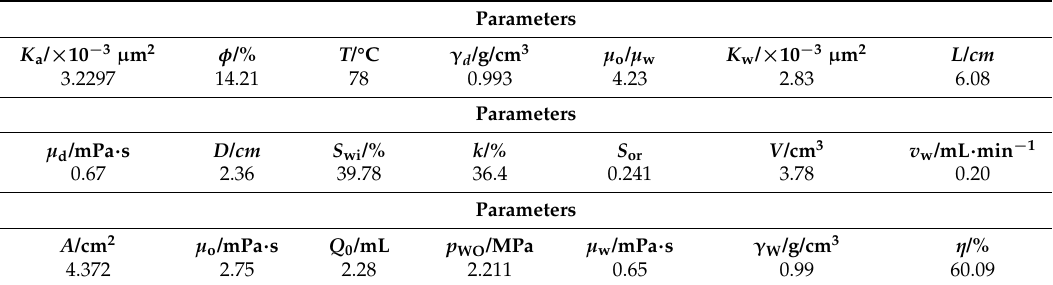
Table 12. The core 32 physical property parameters and experimental conditions. Parameters